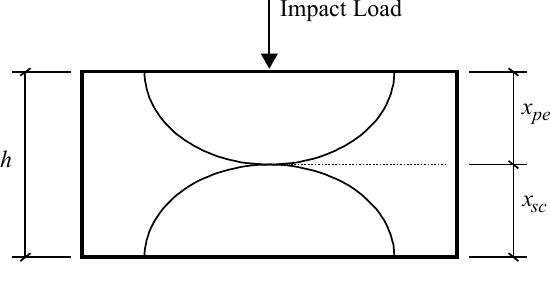
Figure 6. Perforation definition in this paper.